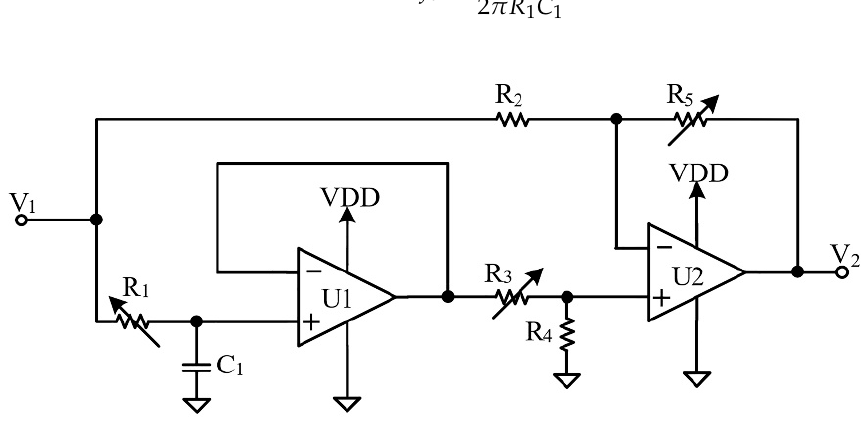
Figure 3. The implementation of the signal conditioning.